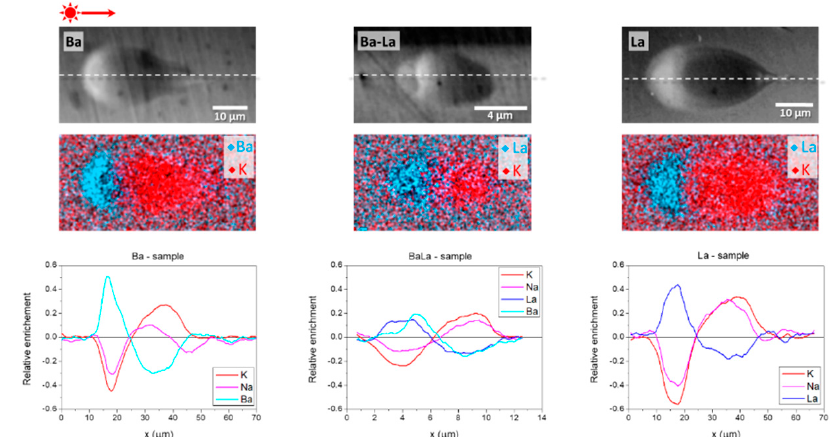
Figure 5. ( Top row) SEM backscattered electron images and EDX compositional maps correspond- ing to Ba, La, and K for structures produced at 700 nJ in the Ba-, La- and Ba-La-glass samples. ( Bottom row) Corresponding composition line scans along the dashed line shown in the SEM im-